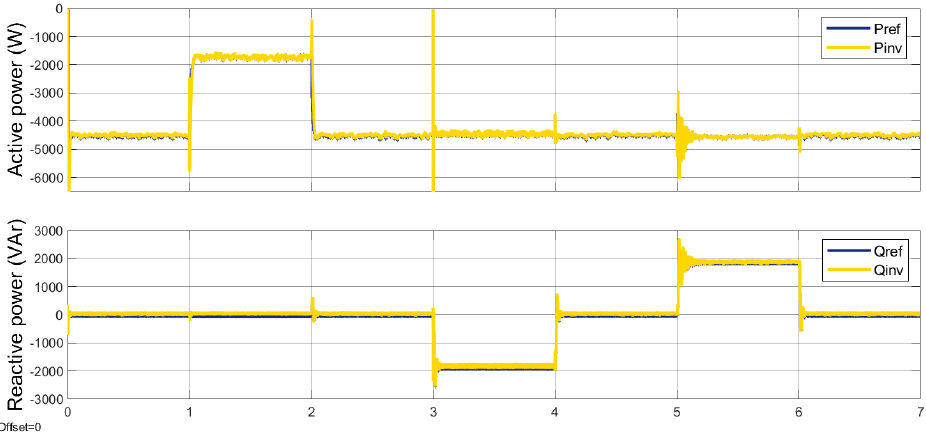
Figure 8. BFO controller output (P ref and Q ref ) and active and reactive power of the inverter (P inv and Q inv ).